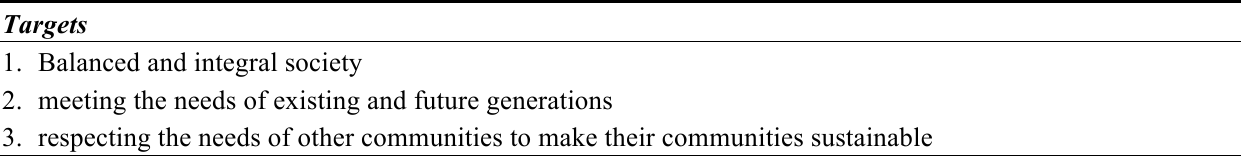
Table 4. Indicators and performance requirements for sustainable communities